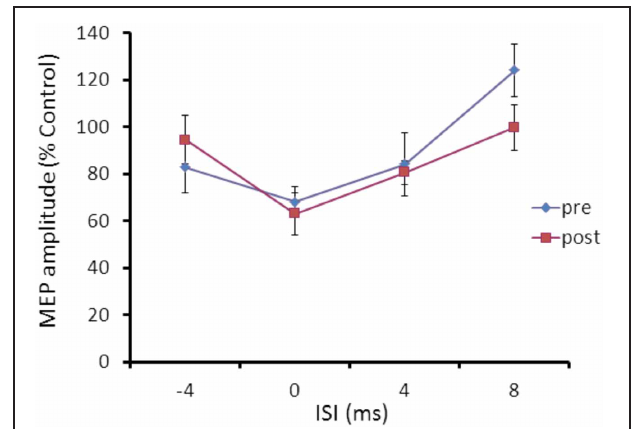
FIGURE 6 | Effects of occipital cTBS on SLAI in AD patients. Error bars indicate standard deviations. The size of MEPs is expressed as a percentage of the MEP evoked by magnetic stimulation alone. Error bars indicate mean standard